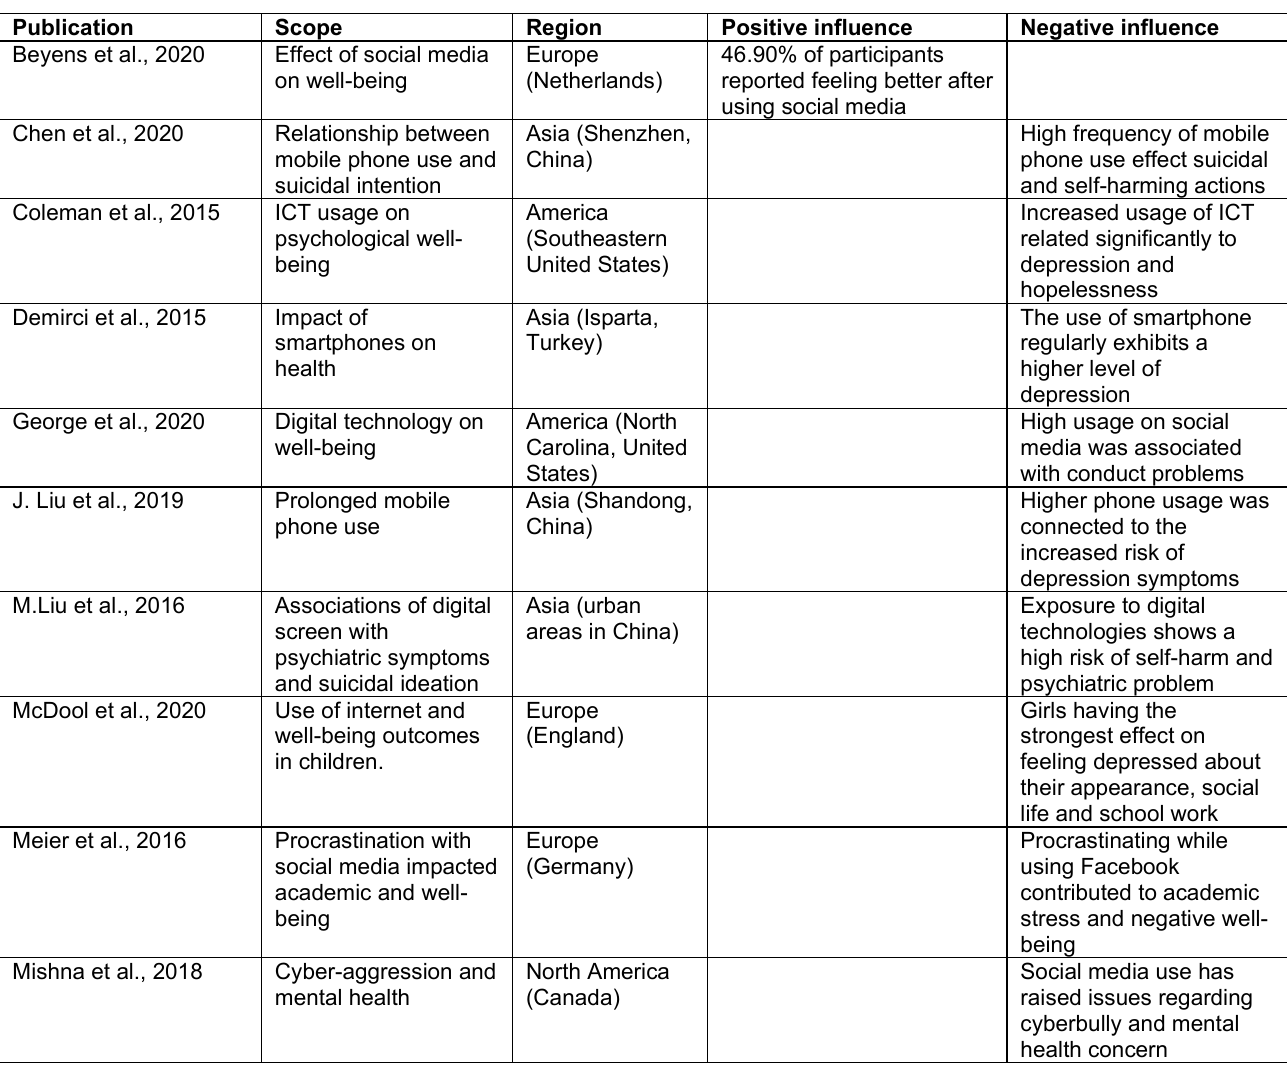
Table 4. Studies on the influence of ICT on